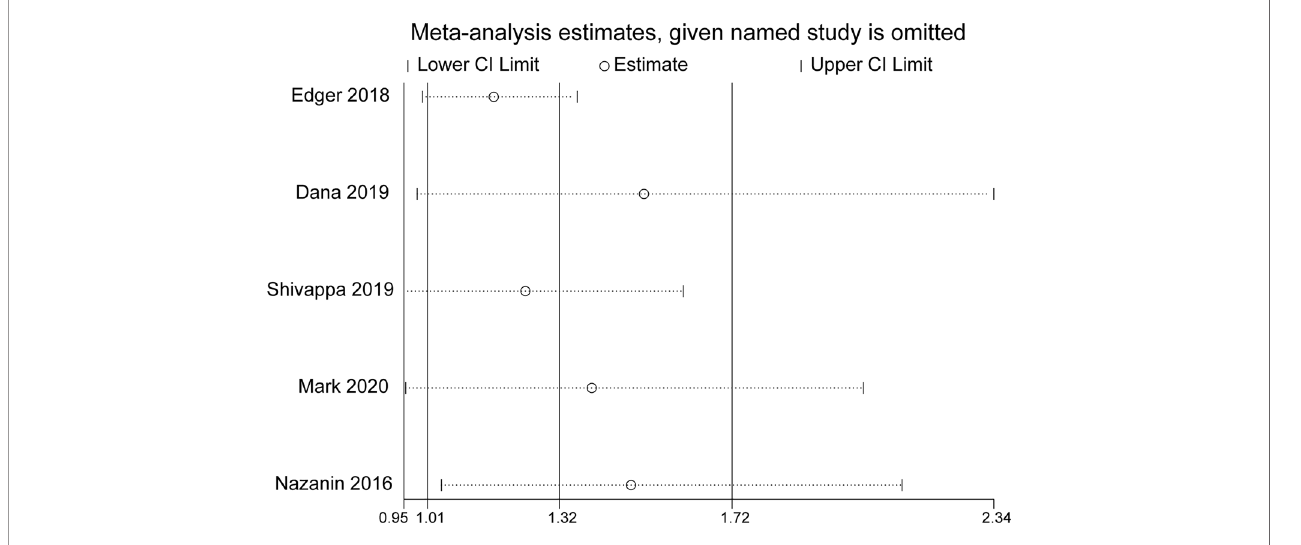
FIGURE 3 | Sensitivity analysis of all included